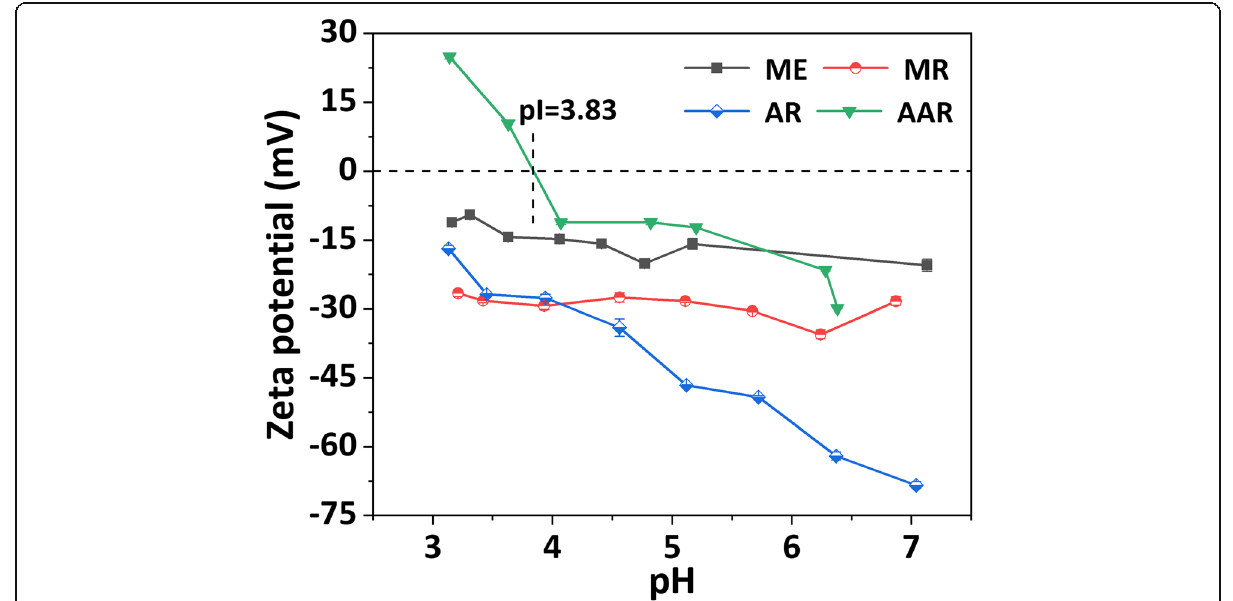
Fig. 2 Effect of pH on zeta potential of retanning